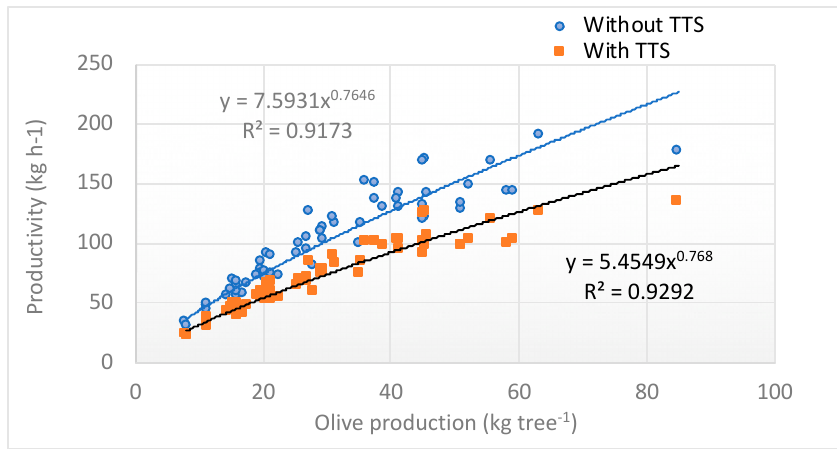
Figure 11. Productivity of the olive harvesting yard, with or without TTS application, as a function of olive production per tree.